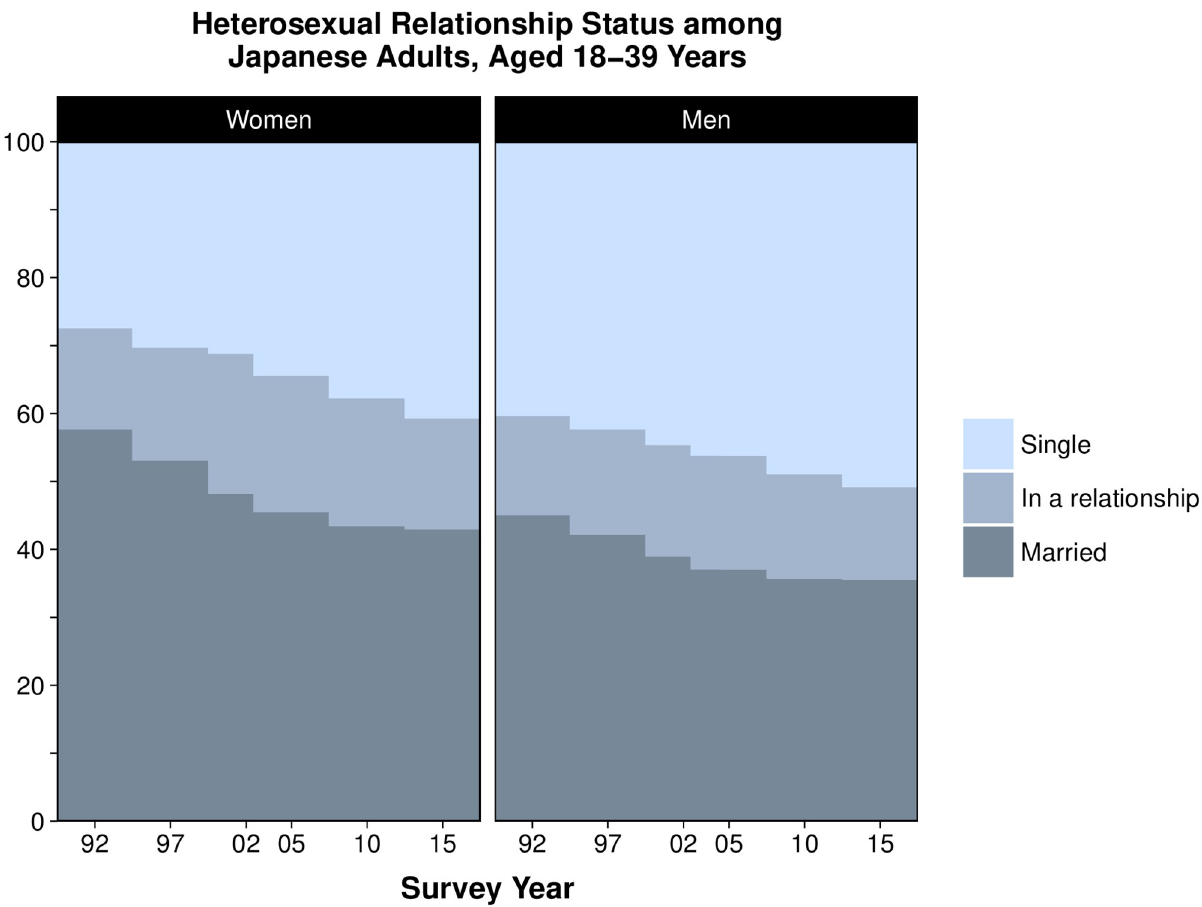
Fig 1. Trends in heterosexual relationships status among Japanese women and men, aged 18–39 years, 1992–2015. Proportions in 1992–2010 were standardized to the age distribution of 2015.